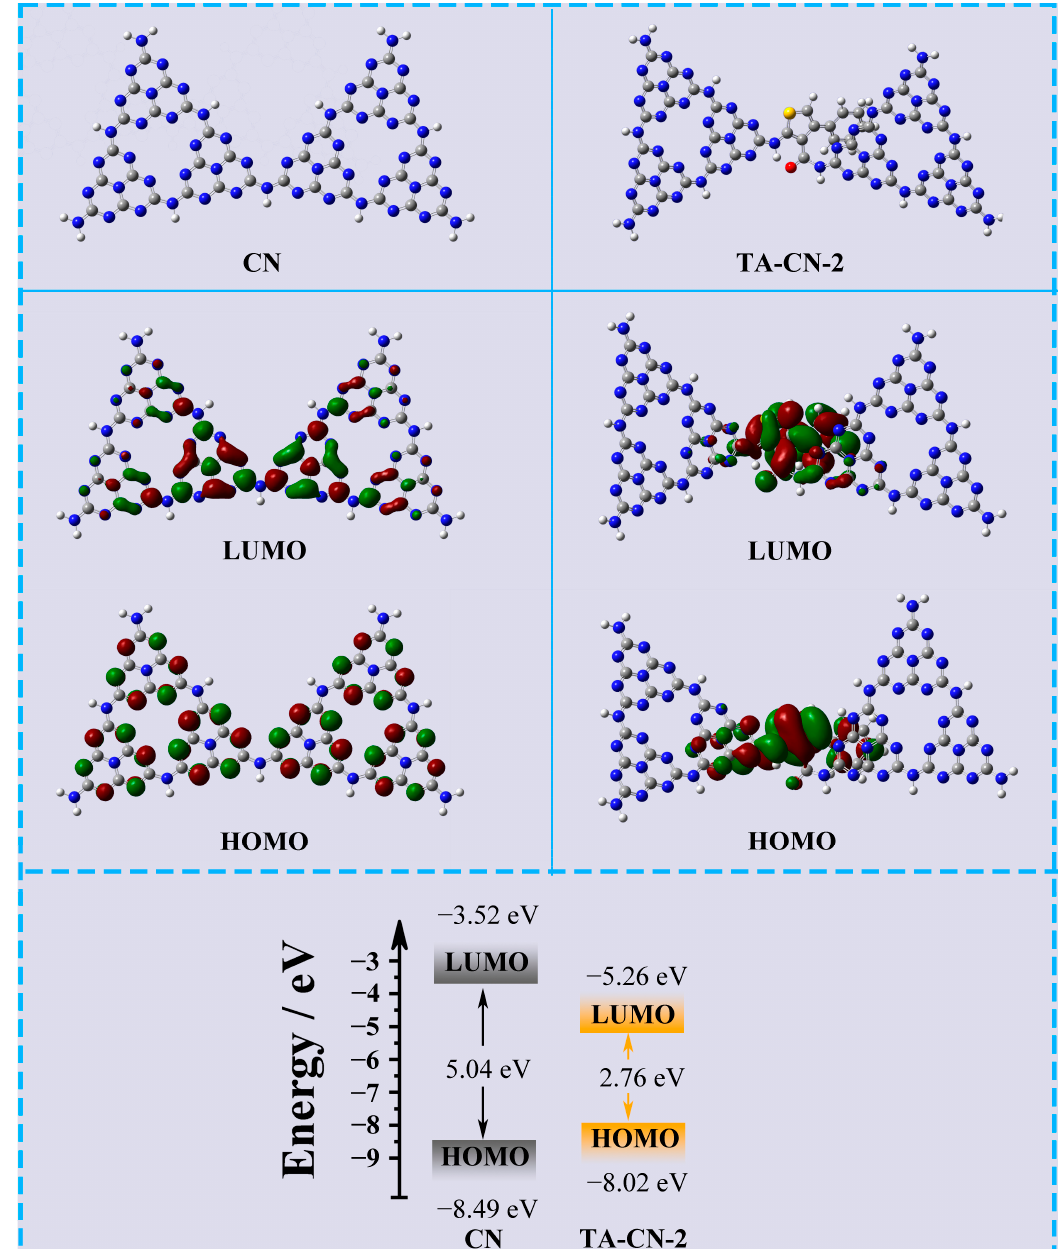
Figure 10. Electronic structure of polymeric trimmer models and optimized HOMO-LUMO energy levels of CN and TA-CN-2.